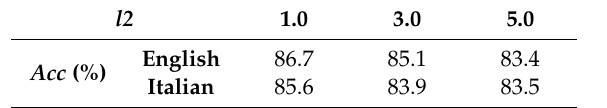
Table 15. Testing accuracy obtained by di ff erent regularization terms 1